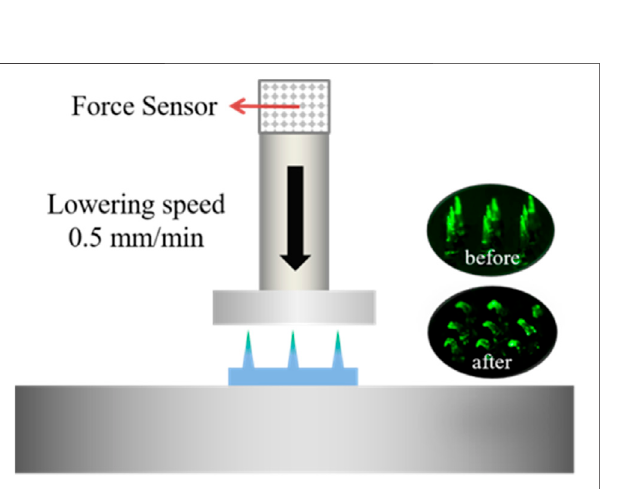
FIGURE 2 | Bright- fi eld (A − C) and fl uorescent (a, b, c) micrographs of FITC-insulin loaded MN arrays. Scale bar: 500 μ m.